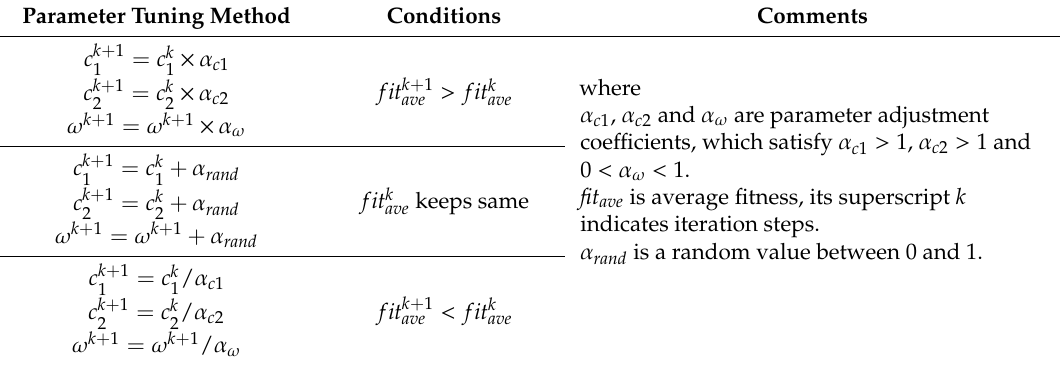
Table 1. Parameter tuning method of variable-parameter particle swarm optimization